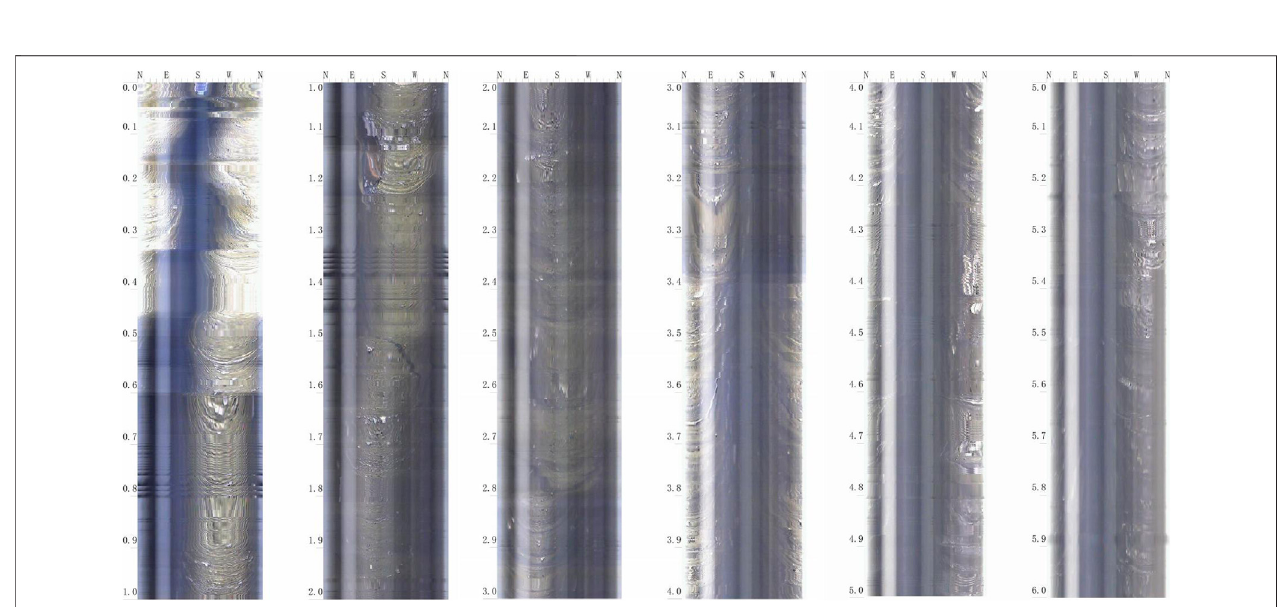
FIGURE 12 | Peeping through 0 – 6 m boreholes in the 11 coal belt roadway in the west-east wing of Zhuji.